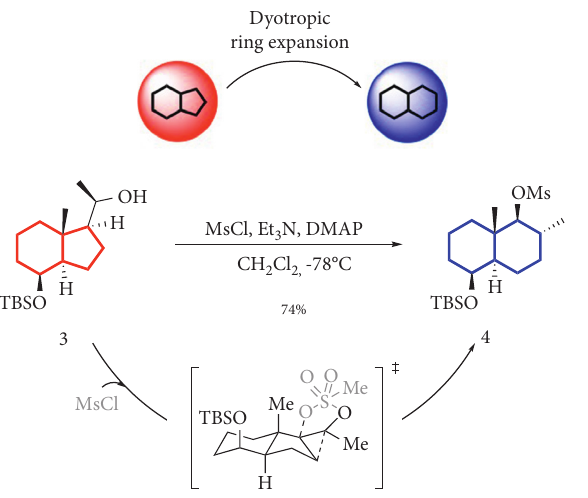
Scheme 1: Ring expansion of 3 via the dyotropic ring expansion to afford decalin 4.